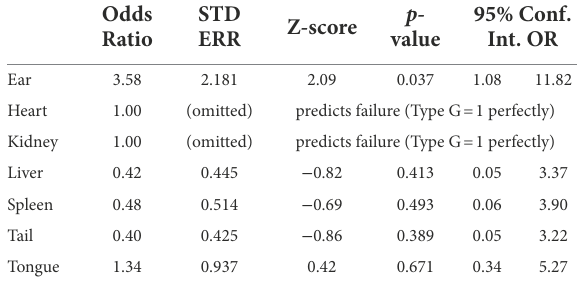
TABLE 3 Borreliella burgdorferi number of types in individual tissues. Number of tissues